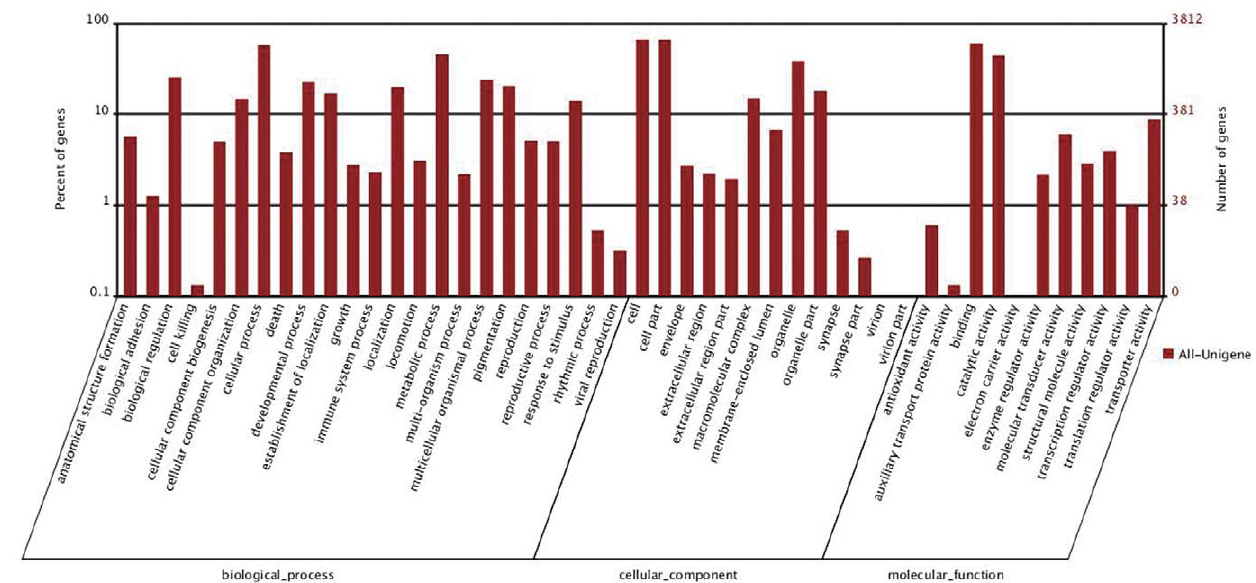
Figure 2. Histogram representation of Gene Ontology classification. GO categories, shown in the x -axis, are grouped into three main ontologies: biological process, cellular component and molecular function. The right y -axis indicates the number of genes in each category, while the left y -axis indicates the percentage of of total genes in that category. The ‘All-unigene’ indicates that the unigenes were those assembled from reads from the SS&RS sample.